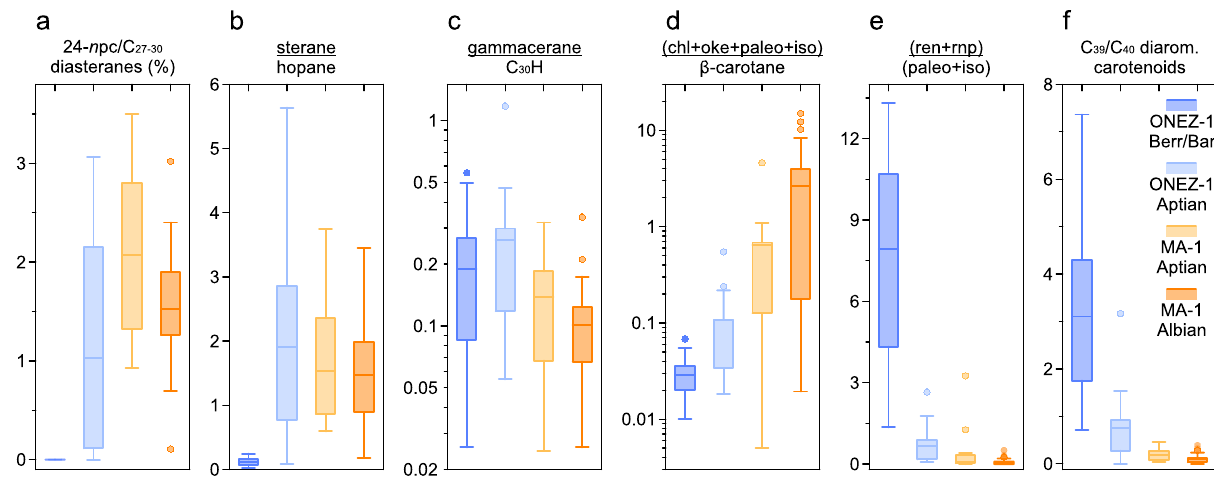
Fig. 2 Box-whisker plots for six biomarker proxies. a The percentage of 24-n-propylcholestane (24- n pc) over C 27 to C 30 diasteranes, as de fi ned in the Supplementary Table 1. b The relative abundance of sterane and hopane compounds. c Gammacerane over C 30 αβ hopane (C 30 H). d The sum of chlorobactane (chl), okenane (oke), paleorenieratane (paleo), and isorenieratane (iso) relative to β -carotane. e The ratio of renieratane (ren) and renierapurpurane (rnp) relative to paleorenieratane and isorenieratane. f The relative abundance of C 39 and C 40 diaromatic carotenoids. Samples were separated into four groups based on wells and formations. Samples from Maculungo-1 (MA-1) were divided into Albian (MA-1 Albian) and Aptian (MA-1 Aptian), while samples from ONEZ-1 were divided into Aptian (ONEZ-1 Aptian) and Berriasian/Barremian (ONEZ-1 Berr/Bar). The lower and upper box boundaries for each group of data points represent fi rst and third quartiles of the dataset, while the line within each box represents the mean value. The whiskers ( “ error-bars ” ) are de fi ned by 1.5 times of interquartile range (IQR), while colored dots are “ outliers ” . The interpretation of each proxy is discussed in the main text and supplementary fi